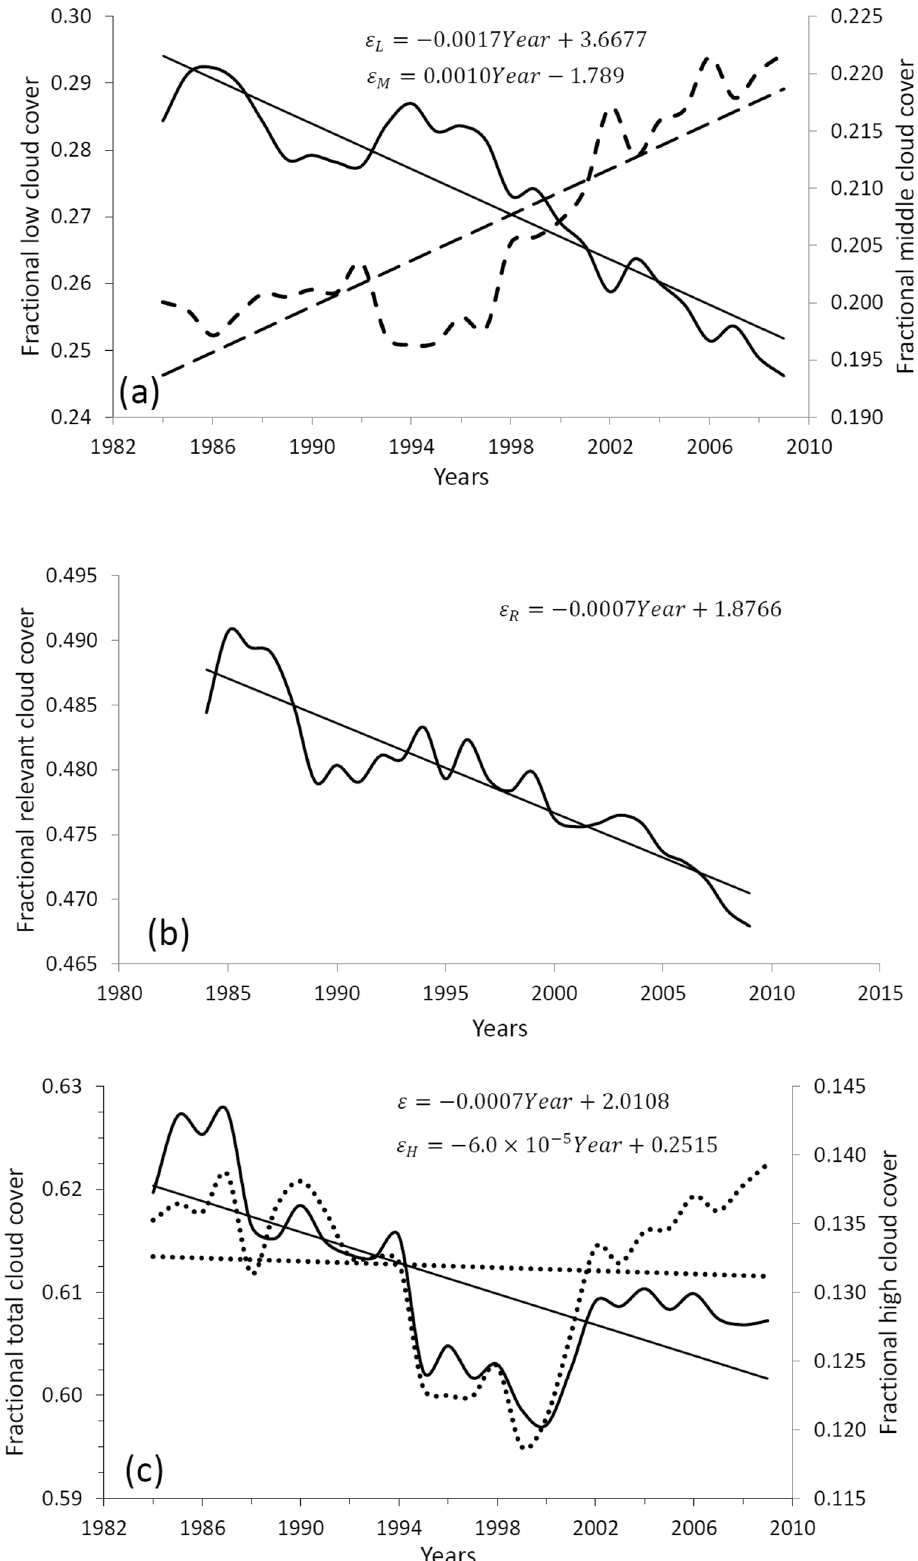
Figure 2. Global and annual average of fractional cloud cover during the 26-year period from 1984 to 2009 obtained from the ISCCP database. Part ( a ) corresponds to ε L (solid curve) and ε M (dashed curve); the part ( b ) to ε R = Min { ε L + ε M , 1 } and the part ( c ) to ε = Min { ε L + ε M + ε H , 1 } (continuous curve) and to ε H (dotted